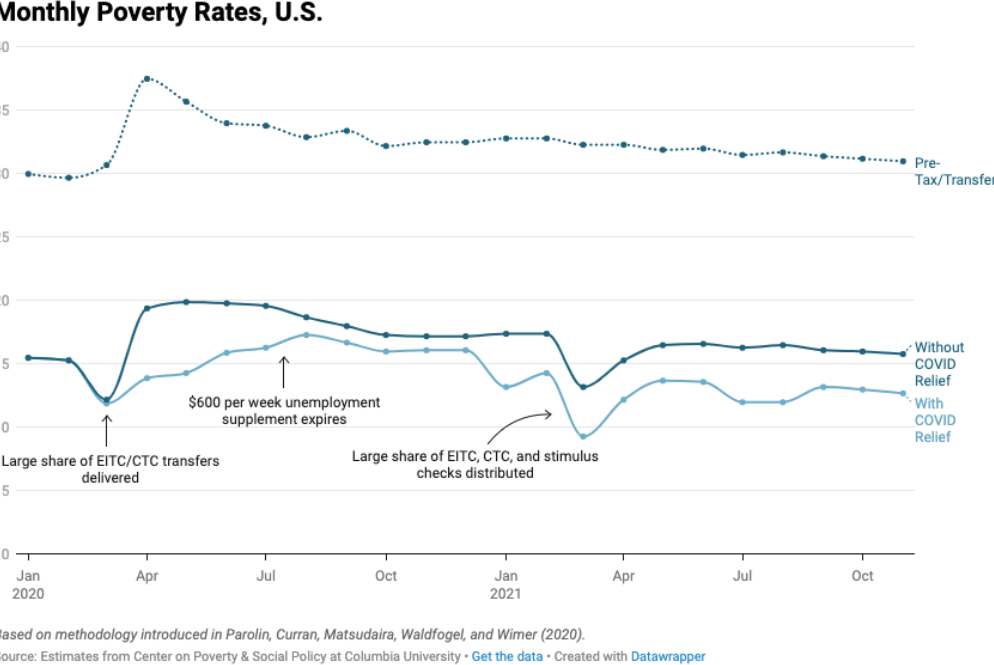
Figure 5. Monthly estimates of the Supplemental Poverty Measure from the Center on Poverty and Social Policy at Columbia University, January 2020–July 2021 [31]. COVID-19 relief efforts such as the stimulus payments prevented higher US poverty rates during the pandemic. Permission for usage of this chart was obtained from Columbia University’s Center on Poverty and Social Policy.